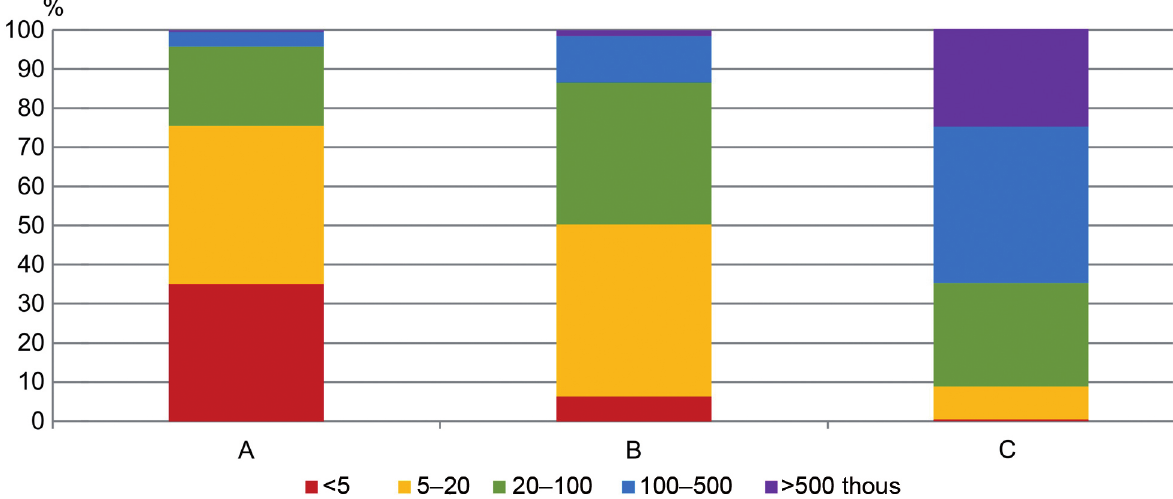
Fig. 2. Size structure of Polish towns as of 31 December 2012. Explanation: A – percentage of Polish towns by size class; B – percentage of towns with TI projects in public buildings co-financed by the rOPV (2007–2013) by town-size class; C – percentage of population living in particular classes of towns where thermal improvement projects co-financed by the rOPV (2007–2013) were carried out in public buildings. Source: developed by the authors on the basis of data available from the LDB CSO and European Funds